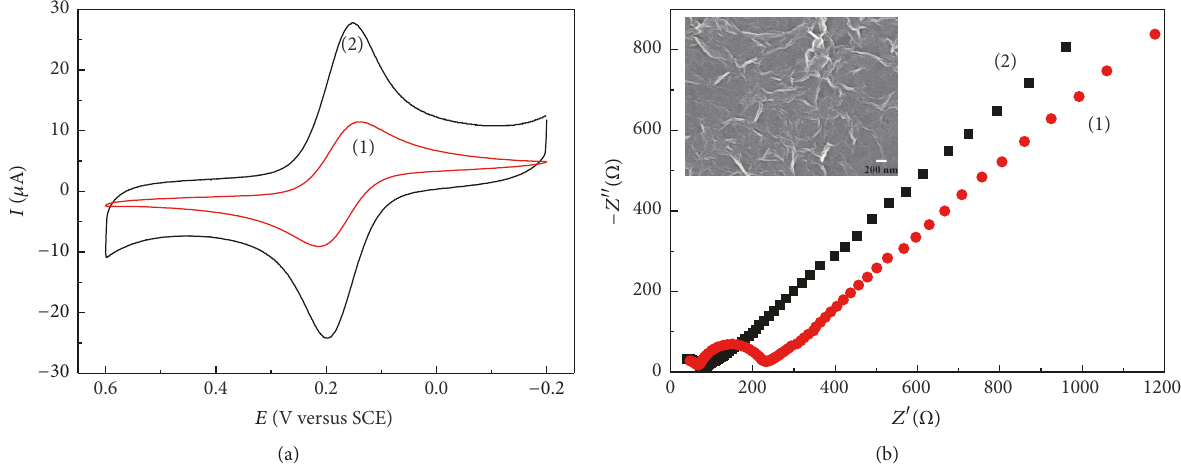
Figure1:(a)CVcurvesof1mM[Fe(CN) 6 ] 3−/4− in0.1MPBS(pH7.0)atascanrateof50mVs −1 and(b)Nyquistplotsof10mM[Fe(CN) 6 ] 3−/4−